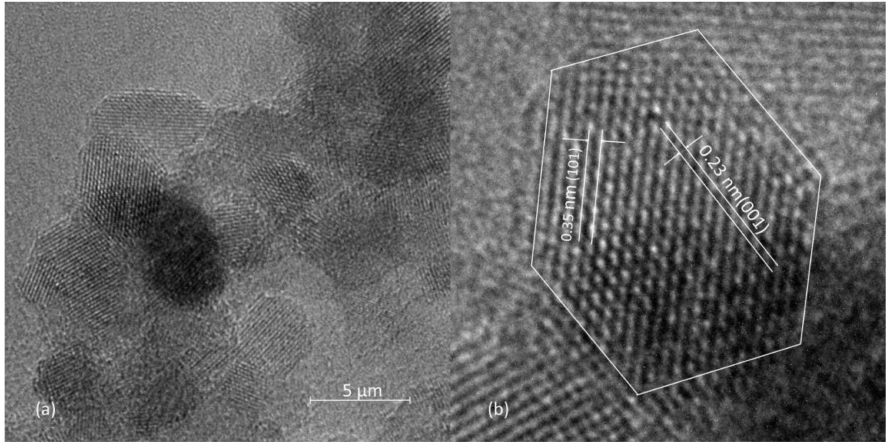
Figure 3. ( a ) HRTEM image of the prepared photocatalyst, ( b ) enlarged portion showing lat- tice